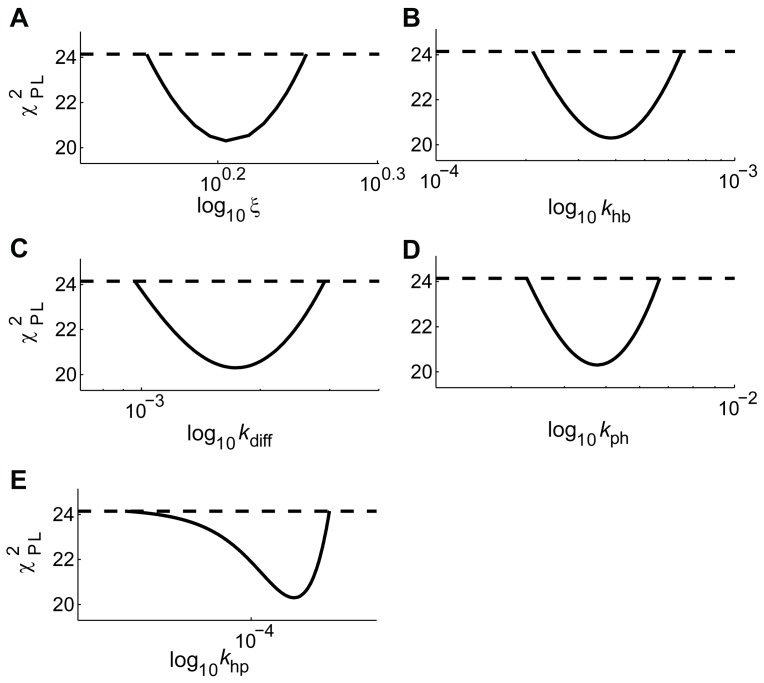
Profile likelihood parameter uncertainties for the proposed model.The solid lines show the profile likelihood versus parameter value for model M0, given the estimation data. The dashed lines show 95% confidence interval. In Table 3 the numerical values and definitions of each parameter were summarized. The results show that all parameters are structurally identifiable, i.e. they have a finite limit.